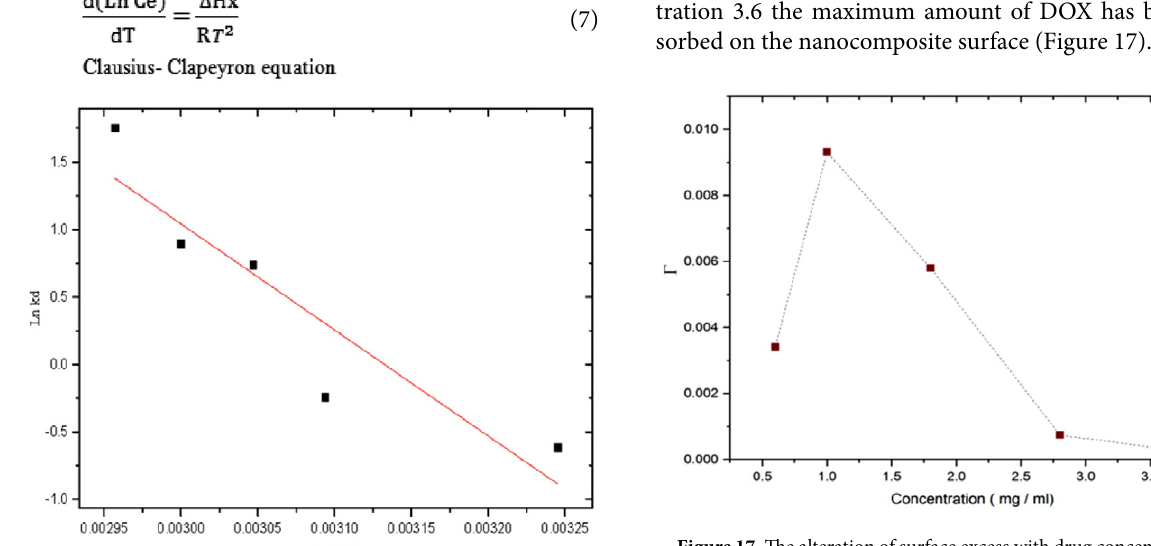
Figure 17. The alteration of surface excess with drug concentration.